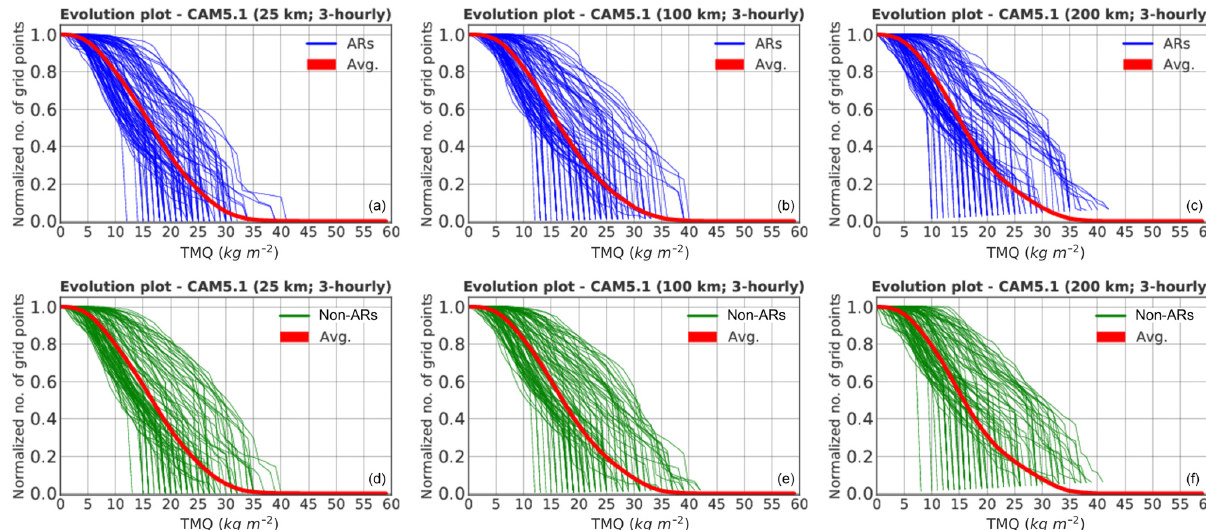
Figure 11. Normalized evolution plots of averaged (red curves) and 100 arbitrarily selected topological feature descriptors of ARs (blue curves; a, b, c ) and non-ARs (green curves; d, e, f ) for 3-hourly temporal resolution and 25km (a, d) , 100km (b, e) and 200km (c, f) spatial resolutions of the CAM5.1 simulation data. The plots illustrate how topological descriptors vary versus IWV. They show the topological representation of both AR and non-AR events for each resolution of CAM5.1 model